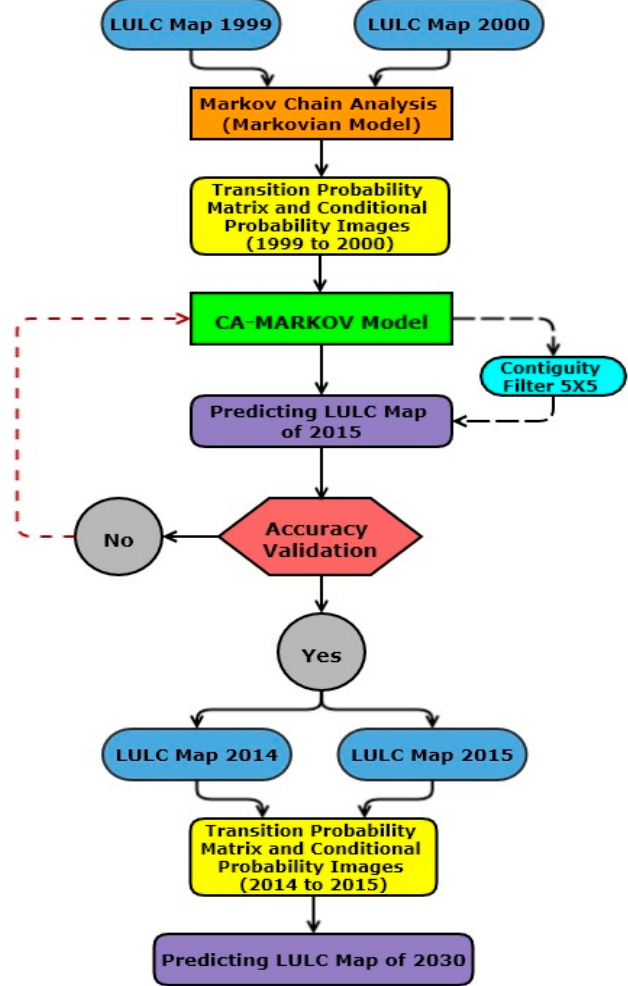
Figure 3. Workflow of the methodology used within CA-Markov LULC future